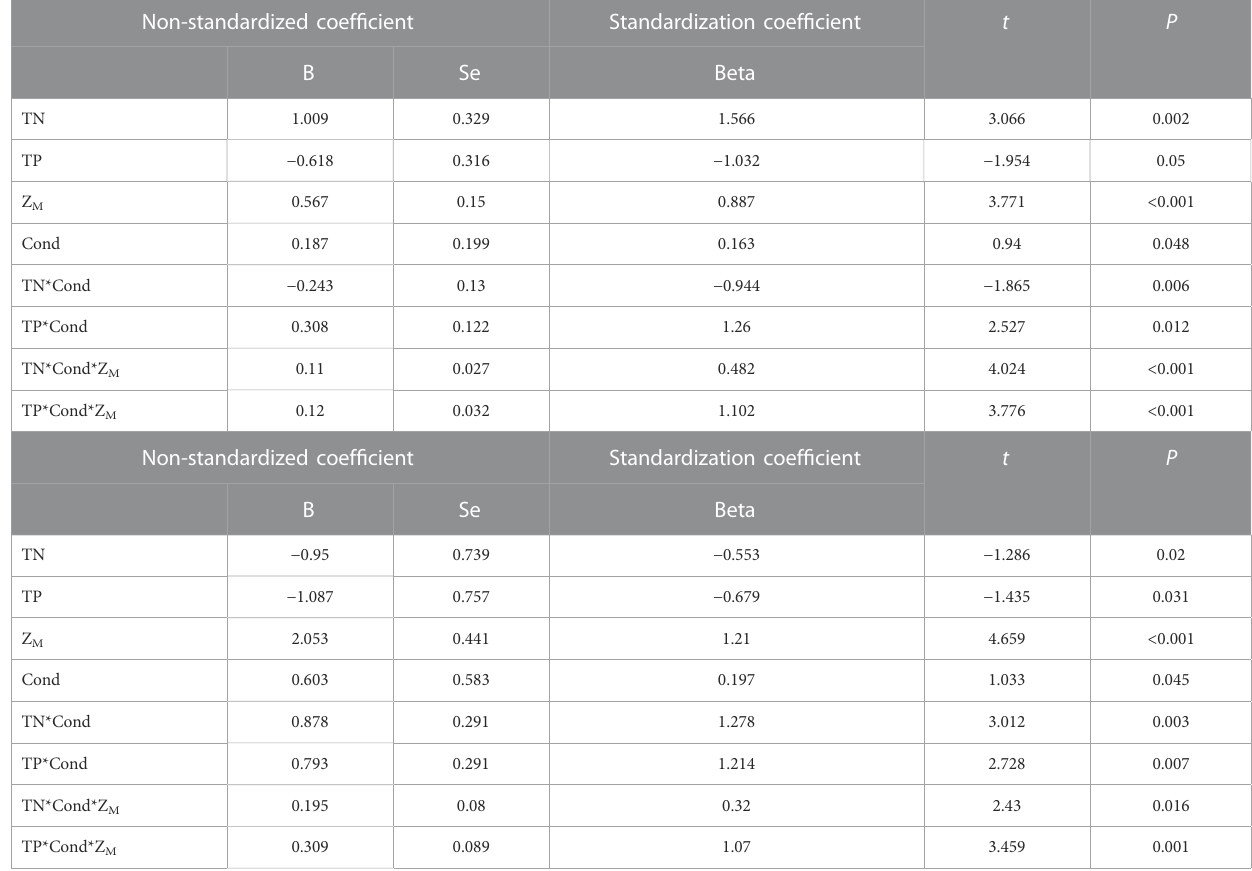
TABLE 3 Analysis of zooplankton species number, biomass and environmental parameters by “ A*B ” regression